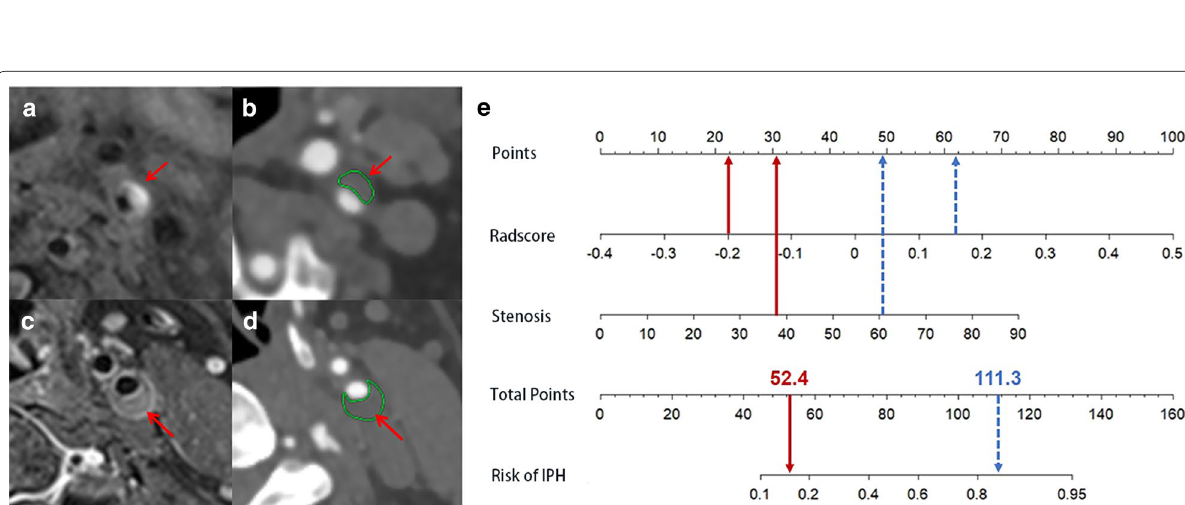
Fig. 5 Application of nomogram to predict probability of IPH. a , b The carotid plaque (arrow) is shown on MRI and CTA. And MRI shows hyper-intensity on T1-weighted imaging suggestive of IPH. c , d The carotid plaque (arrow) is shown on MRI and CTA. And MRI shows no hyper-intensity on T1-weighted imaging suggestive of no IPH. e For patient in a and b (blue dashed arrows), nomogram yields total of 111.3 points and corresponding risk of IPH greater than 0.8. For patient in c and d (red solid arrows), nomogram yields total of 52.4 points and corresponding risk of IPH less than 0.2. IPH Intraplaque =